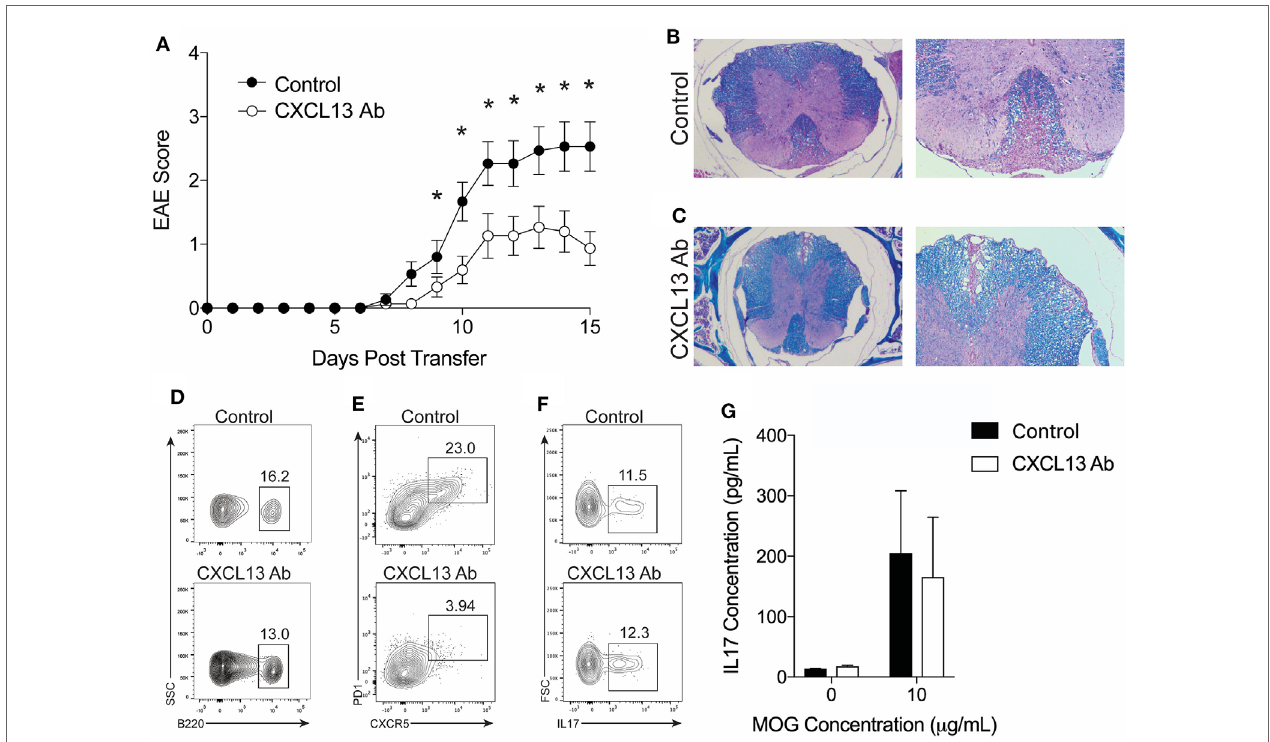
FigUre 6 | CXCL13 antibody treatment protects against TH17-experimental autoimmune encephalomyelitis (EAE) in wild-type mice. TH17-EAE was induced in C57BL/6 mice and treated with either anti-CXCL13 or an isotype control twice a week beginning at Day 0 post-transfer of TH17 cells. (a) Disease score was monitored. Data were compiled from three experiments and statistical significance at each day was determined using a Mann–Whitney test (* p < 0.05, N = 15 total mice per treatment group). Histological analysis of representative spinal cord sections stained with H&E and Luxol Fast Blue in mice treated with (B) isotype control or (c) anti-CXCL13. Representative FACS plots of the percentage of spinal cord-infiltrating (D) B220 + B-cells (in the viable cell gate), (e) CXCR5 + PD1 + TFH cells (in the CD4 + cell gate), and (F) IL-17 + cells (in the CD4 + CD44 + cells gate) in mice treated with anti-CXCL13 or isotype control. (g) MOG-specific IL-17 responses in the spleen were assessed through ELISA ( N = 3 mice per